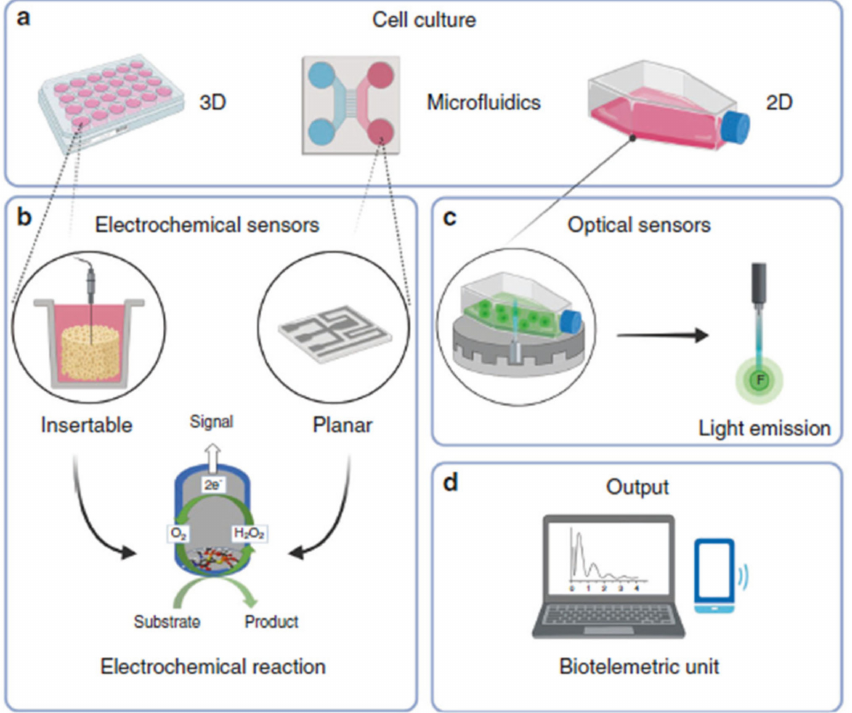
Figure 14. Applications of biosensors in the tissue engineering field using ( a ) electrochemical tech- niques, ( b ) the optical method, ( c ) real-time monitoring of quality, and ( d ) longitudinal studies (reprinted from Ref. no. [148], copyright 2021, Springer